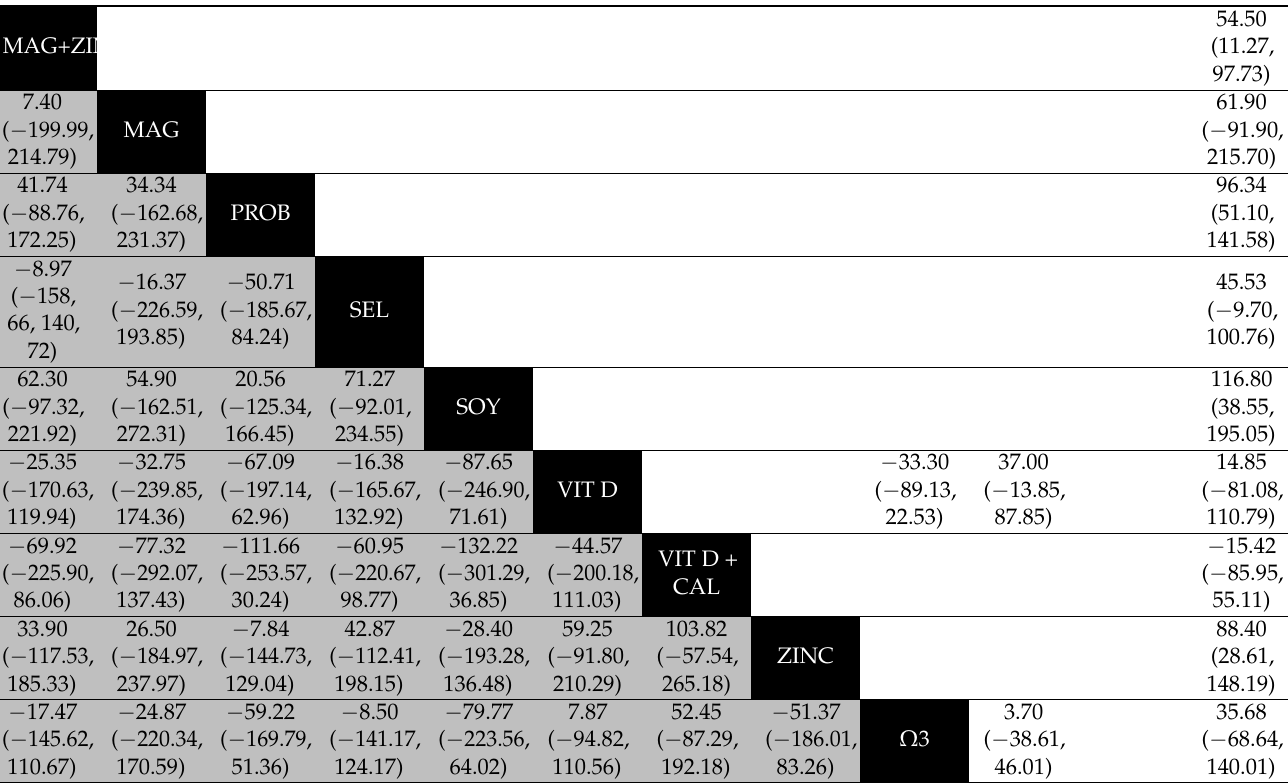
Table 4. Direct and indirect (in grey) estimates of the mean difference of Δ MDA. Each column presents a different intervention.